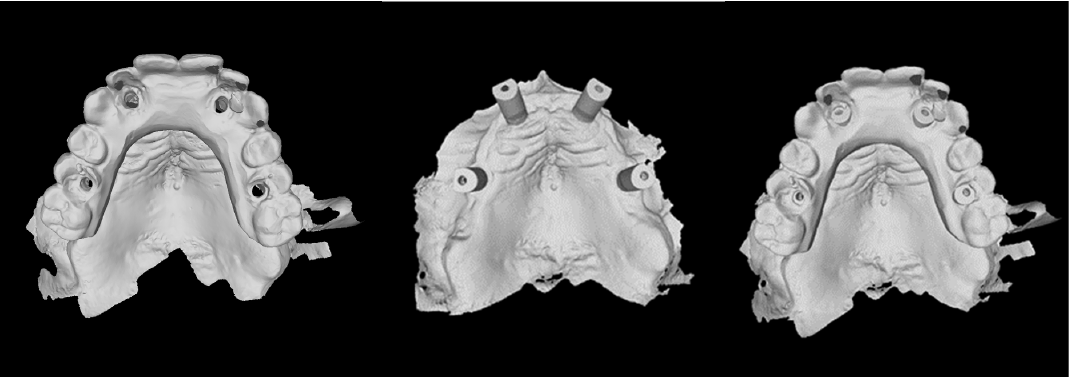
Figure 18. From left to tight: digital impression of the temporary restoration; matching between the two digital impressions; digital impression of the scan abutments in place.